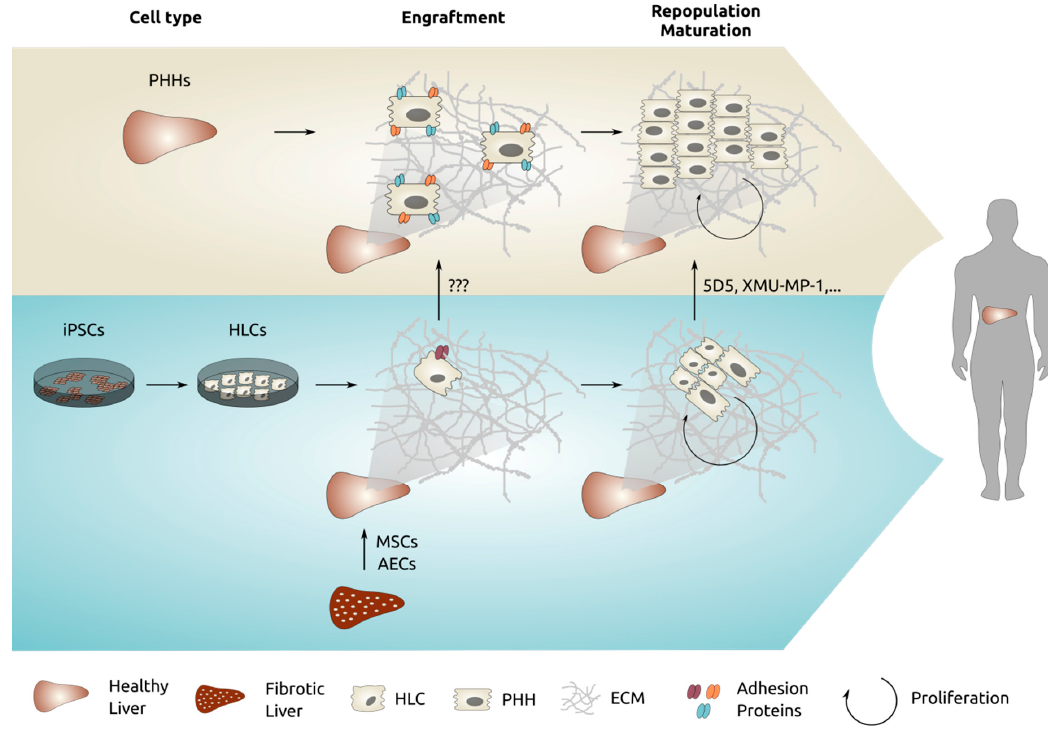
Figure 2. Overview of the processes we believe are required to ensure proper engraftment and repopulation of PHHs into human liver. In blue, the reduced engraftment and repopulation efficiency of iPSC-HLCs is shown, and some strategies to potentially overcome these drawbacks are indicated.